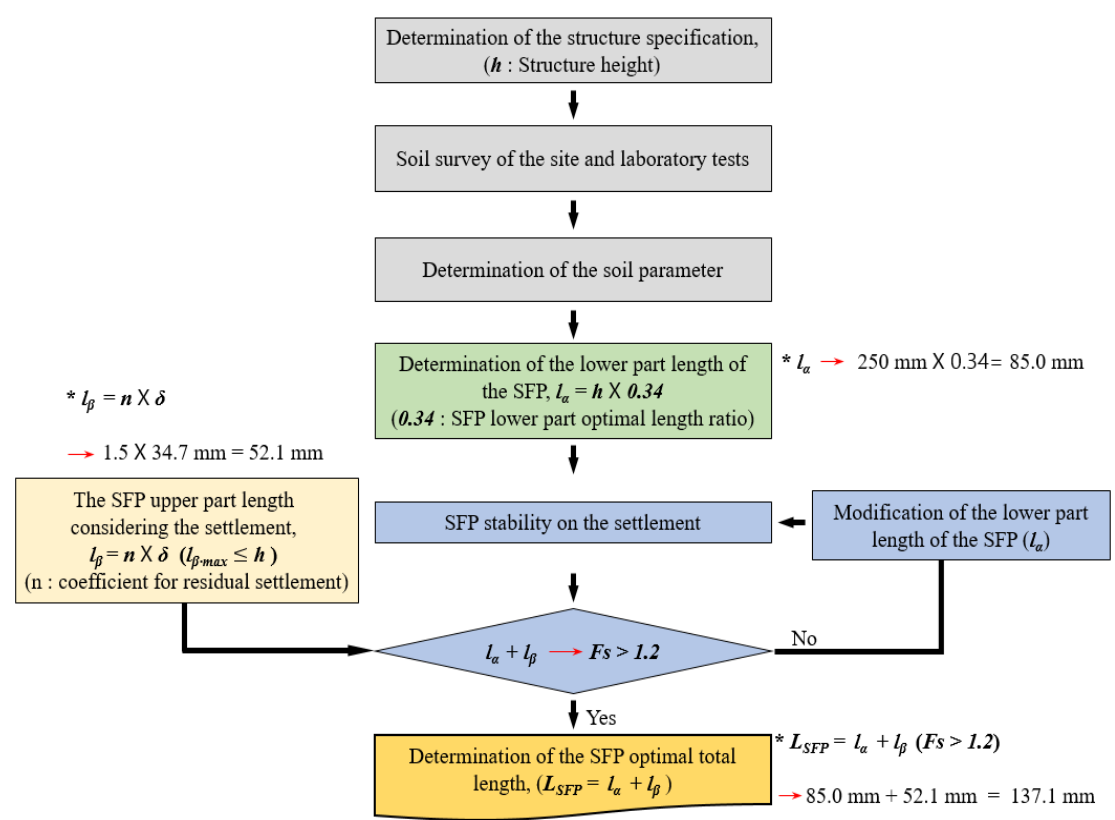
Figure 14. Flowchart for the SFP optimal length estimation and stability analysis.